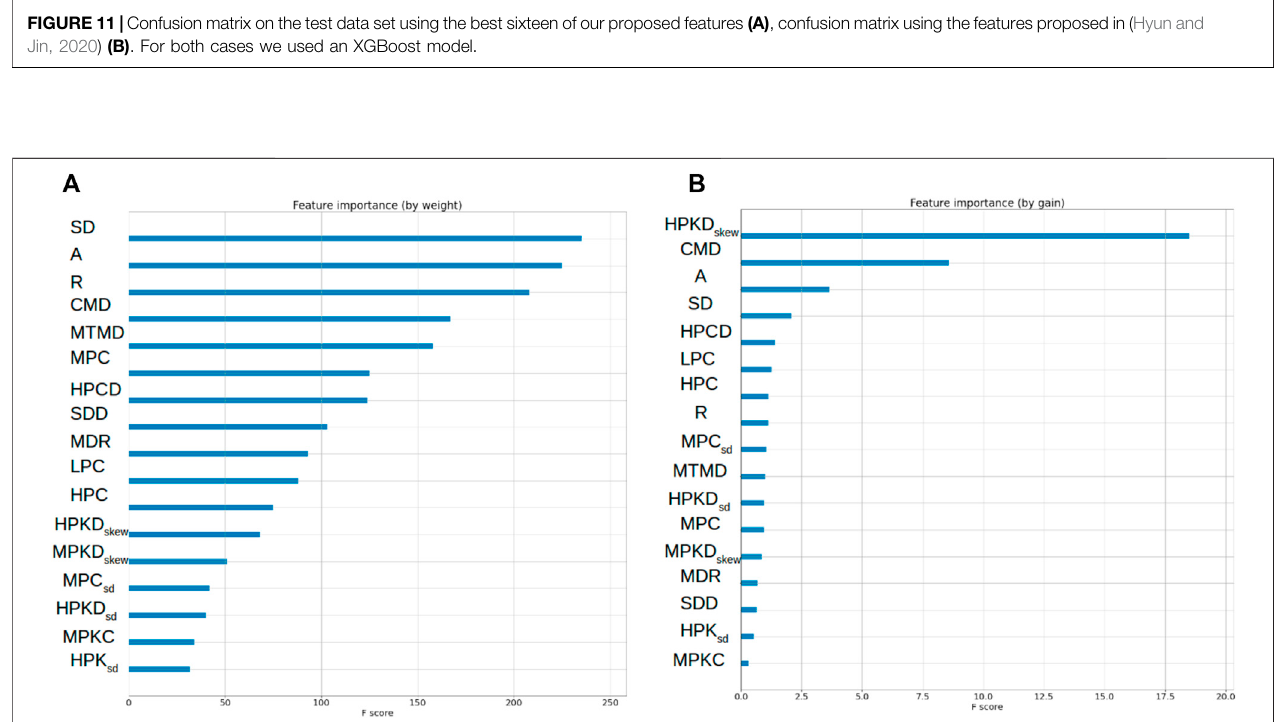
FIGURE 12 | Feature importance by weight (A) and gain (B)